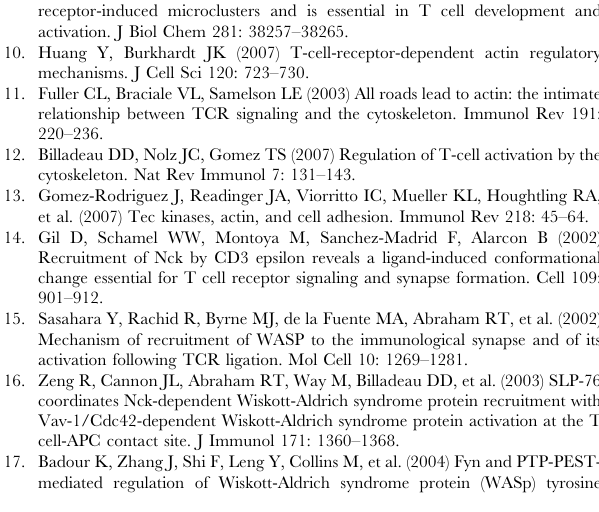
Figure S4 The Vav1 L278Q mutation abrogates GEF activity. (A) Stable expression of GFP-tagged Vav1WT and Vav1GEF- in J.Vav cells was similar to endogenous levels of Vav1 in Jurkats as demonstrated by immunoblotting with anti-Vav1 antibodies and by FACS. (B) (left) In vitro GDP-GTP exchange on increasing concentrations of Rac1 was measured as loss of radiolabeled [3H]- GDP in the presence of unlabeled GTP and a WT Vav1 MBP- DH-PH-ZF fusion protein or (middle) a fusion protein containing the Vav1 DH domain expressing L278Q (MBP-DH(L278Q)-PH- ZF), corresponding to L213Q in N-terminally truncated ‘‘onco’’ Vav, [22,35]. (right) Kinetics of in vitro GDP-GTP exchange as shown in left and middle panels. Bottom panel: kinetic values for GDP-GTP exchange on Rac1 by WT Vav1 MBP-DH-PH-ZF or GEF-inactive MBP-DH(L278Q)-PH-ZF, as determined by Line- weaver-Burk plot shown above. Found at: doi:10.1371/journal.pone.0006599.s004 (0.17 MB TIF) Figure S5 Activation of NFAT and NFkB luciferase by PMA and Ionomycin is Vav-independent. NFAT (A) or NF k B (B) luciferase reporter assays of untreated and PMA and ionomycin- activated J.Vav, J.Vav1WT and J.Vav1GEF- cells. Data are mean 6 SD n . 5 experiments. Found at: doi:10.1371/journal.pone.0006599.s005 (0.09 MB